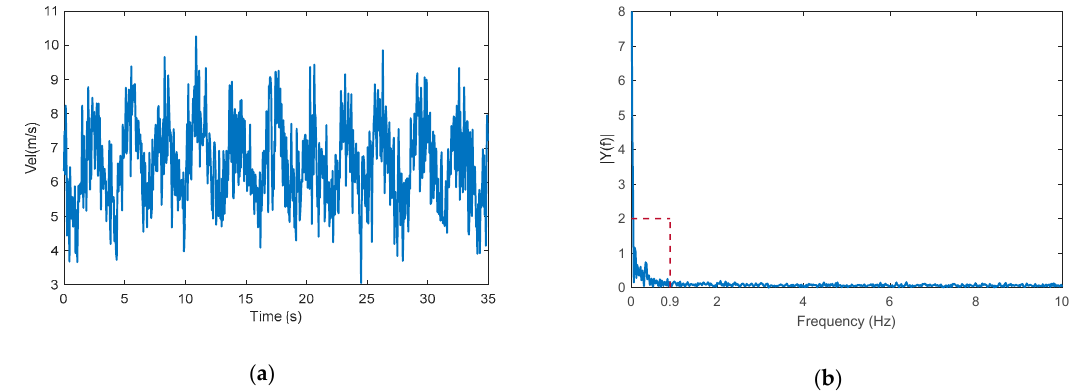
Figure 7. The speed and frequency of the gusty wind disturbance in the experiments: ( a ) The speed of the gusty wind disturbance; ( b ) The frequency domain diagram of the gusty wind disturbance.